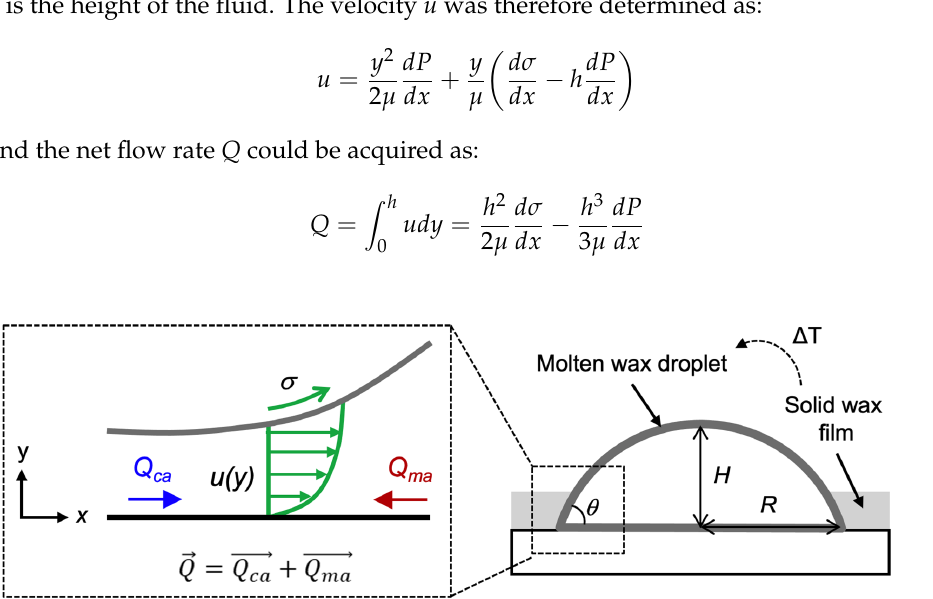
Figure 2. Theoretical modeling of the phase-transition activity of the waxy film, where H , R , θ , Q ma , and Q ca denote the height, radius, and contact angle of wax droplet; and the flow rates induced from Marangoni and capillary effects, respectively. σ is force applied along with the fluidic flow, and u ( y ) is the flow velocity. The pressure P acting in the fluidic flow could be simplified as P = ρ g ( h − y ) − σ ( d 2 h / dx 2 ), where ρ and g are the density of molten wax and the gravity, respectively. Since the fluidic layer was assumed to be very thin, the pressure P could be then expressed as P = − σ ( d 2 h / dx 2 ), and the derivative P versus the x axis could be expressed as: